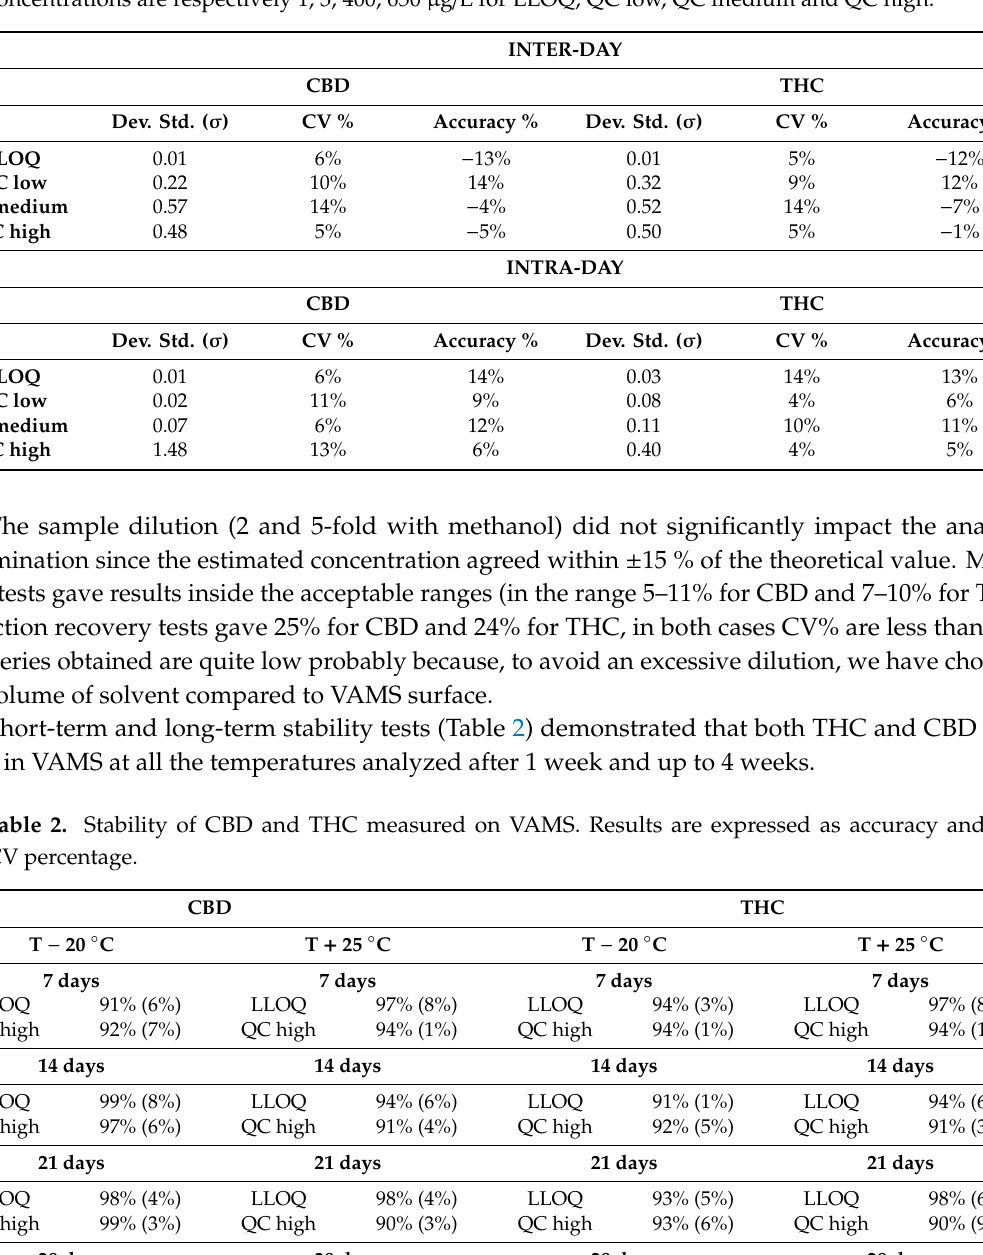
Table 1. Results of Intra-day and inter-day accuracy and reproducibility assays. The quality controls concentrations are respectively 1, 3, 400, 650 µ g / L for LLOQ, QC low, QC medium and QC high.